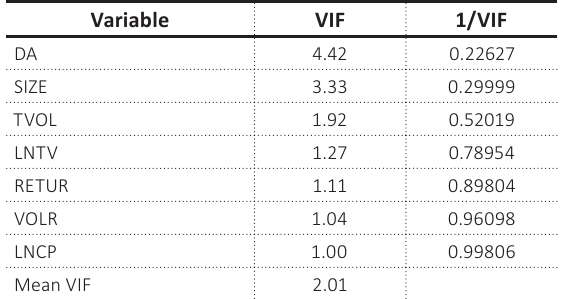
Table 3. The multicollinearity matrix